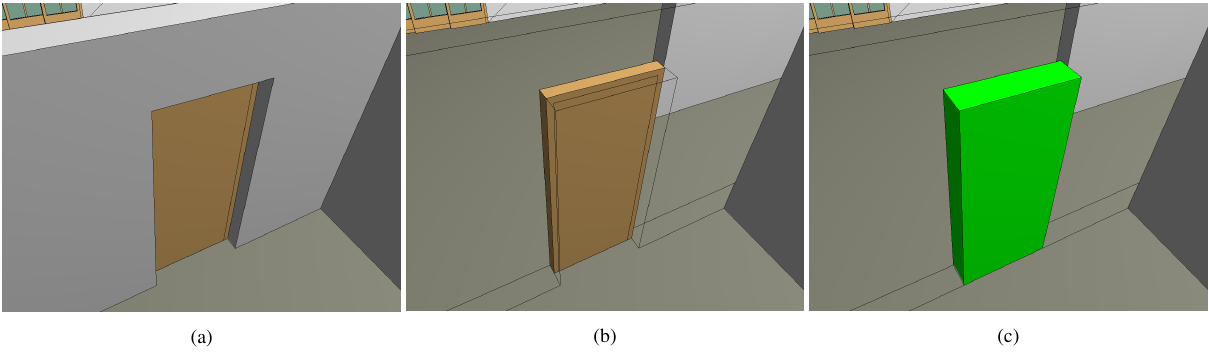
Figure 4. (a) A door in an IFC model. (b) The components corresponding to the IfcDoor class (brown). (c) The space (green) corresponding to the IfcOpeningElement .